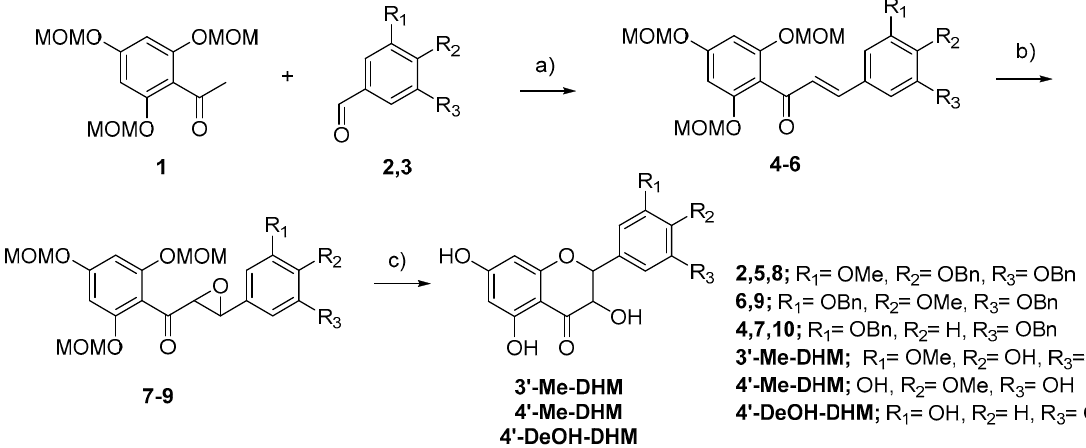
Figure 4. Synthesis route of 3 ′ -Me-DHM, 4 ′ -Me-DHM, 4 ′ -DeOH-DHM (a) NaOH, EtOH/H 2 O (b) H 2 O 2, NaOH, MeOH/Dioxane (c) 1. HCl, MeOH, THF 2. (4 ′ -Me-DHM only) Pd/C, H 2 , MeOH .